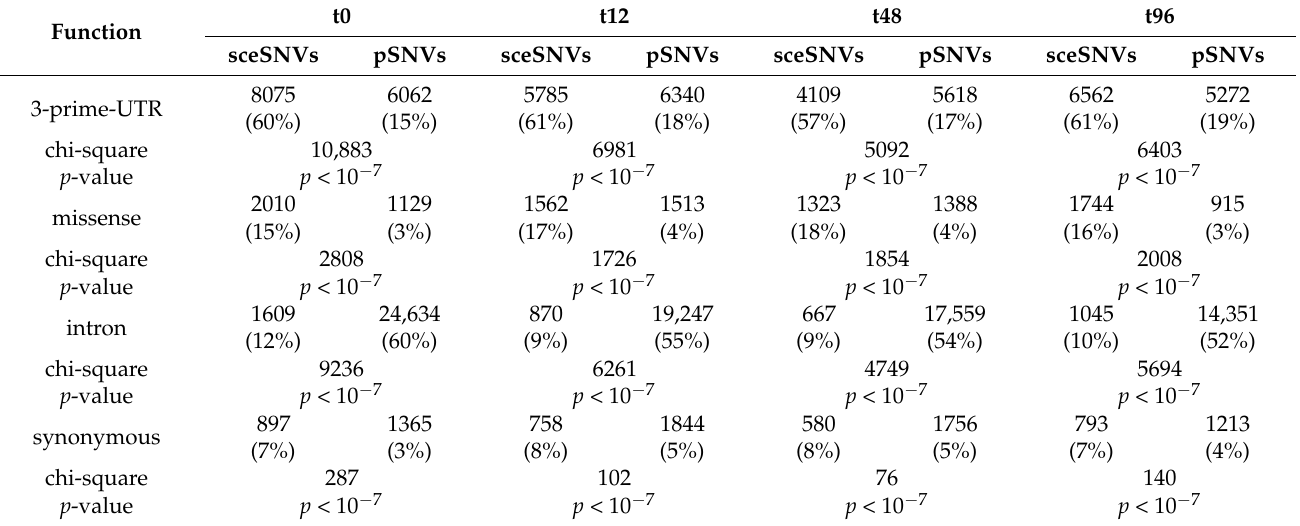
Table 3. Distribution of functional annotations between sceSNVs and pSNVs (chi-square comparisons).